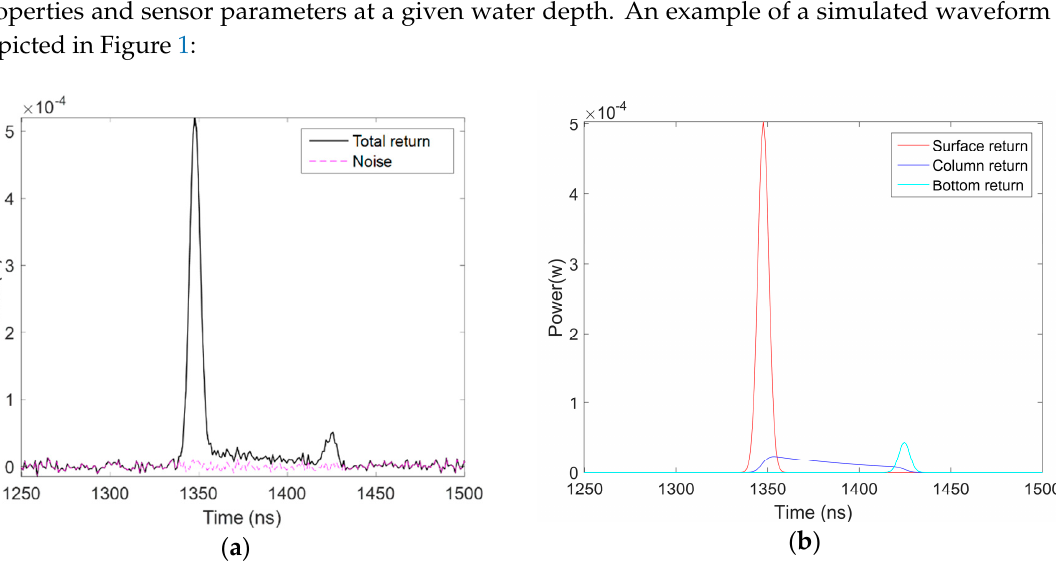
Figure 1. An example of a simulated return waveform using airborne sensor parameters: ( a ) a return waveform with noise; and ( b ) the return waveform without noise, which is decomposed into surface return, column return, and bottom return.